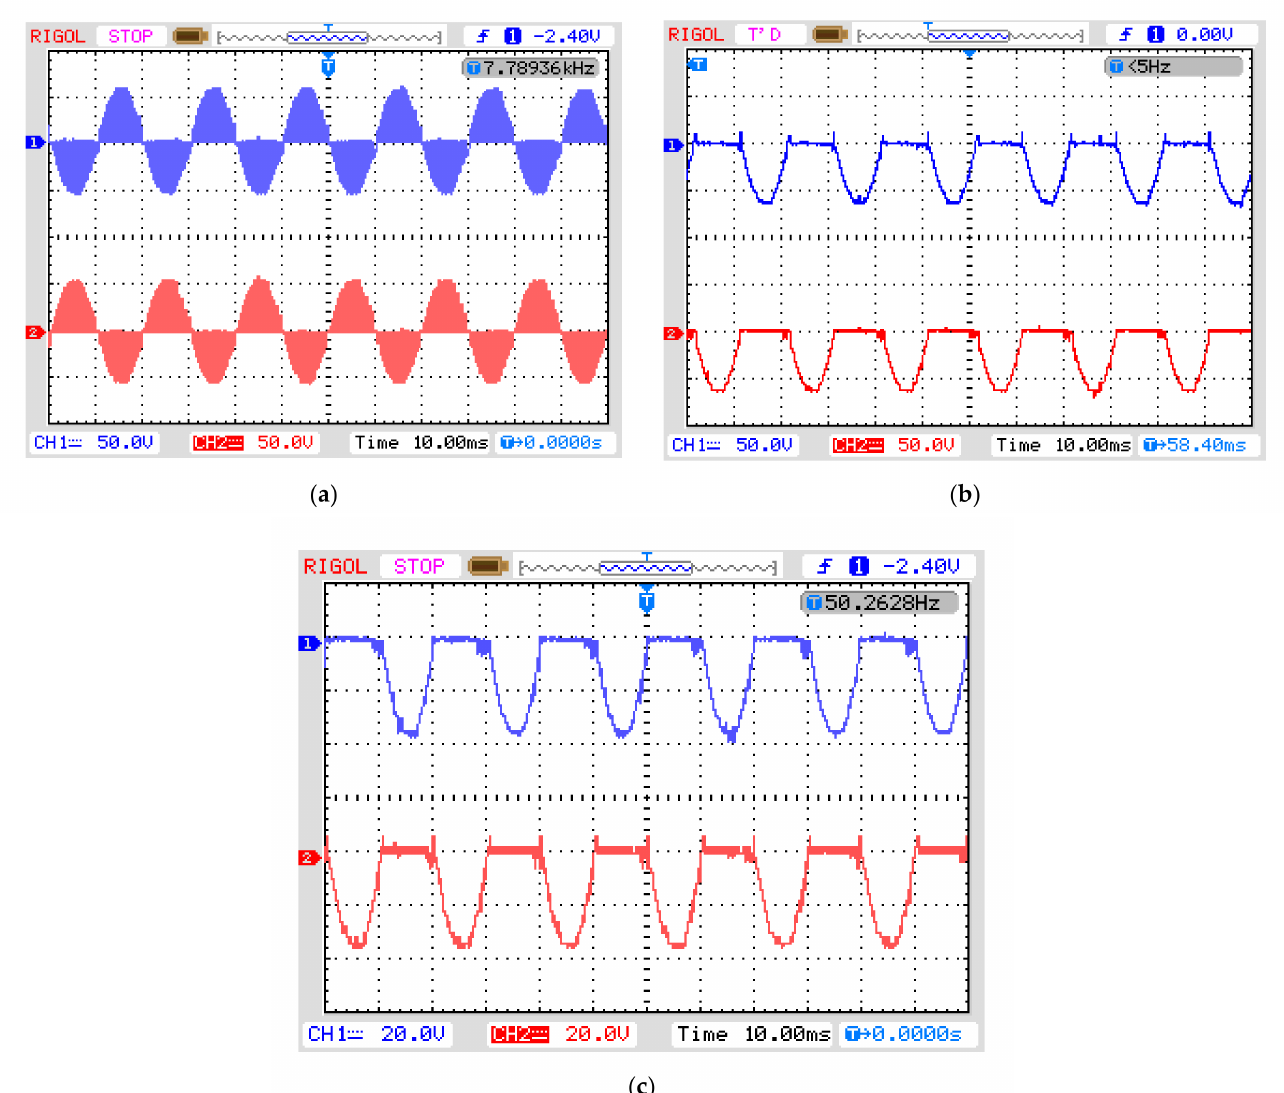
Figure 13. Practically gained voltage waveforms developed across the semiconductor devices: ( a ) Q 4 , D 5 (blue) and Q 4 , D 5 (red); ( b ) Q 1 (blue) and Q 3 (red); ( c ) D 1 , D 2 (blue) and Q 3 , D 4